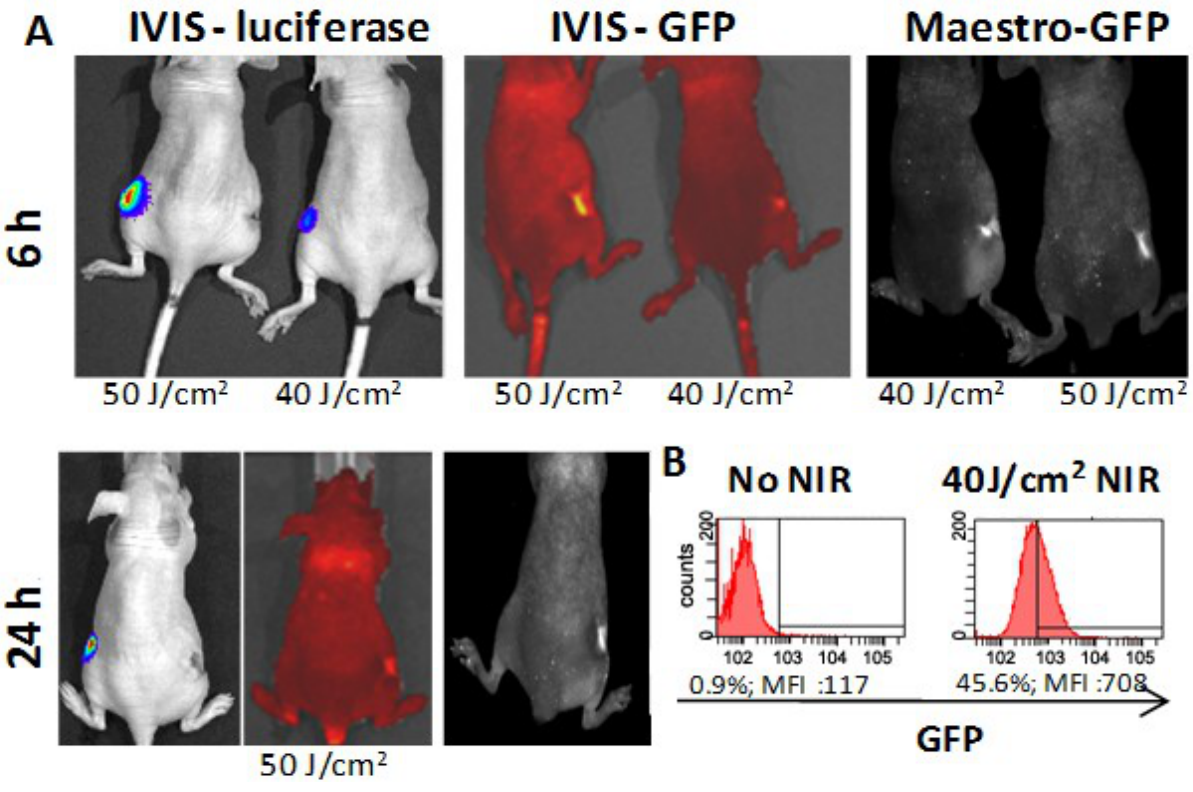
Figure 5. In vivo imaging of luciferase and GFP expression after NIR laser